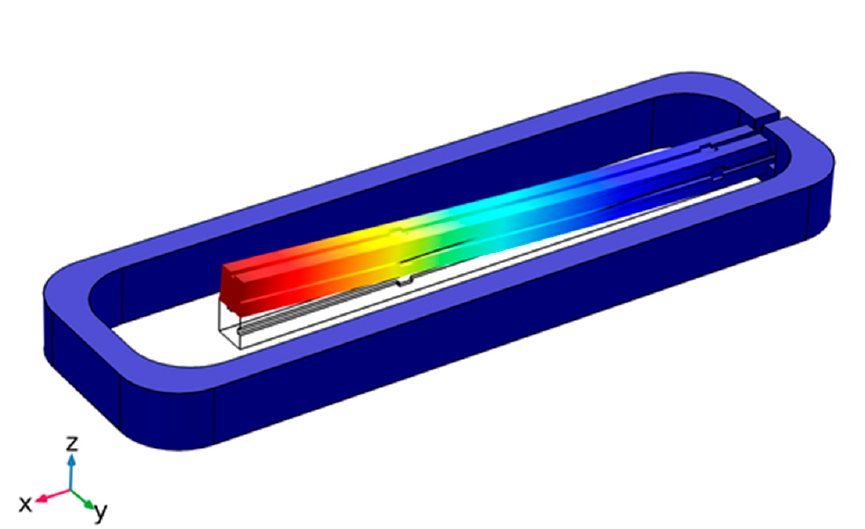
Figure 2. First eigenmode of the printed structure, determined using COMSOL Multiphysics ® . The frequency-dependent deflection of the structure was studied by applying a 10 N load at the cantilever free edge with a harmonic perturbation with frequencies between 10 and 800 Hz. The maximum displacement of the cantilever was calculated and compared with the experimental results for the z-direction, as presented in Figure 3a. The experi- mental data were attained by applying a sinusoidal acceleration with a constant 10 m/s 2 amplitude and a frequency in the range of 10 and 800 Hz. The experimental data were in accordance with those calculated analytically where a maximum fast Fourier transform (FFT) peak value at 250 Hz was attained near the eigenfrequency value and as expected. The same procedure was followed for the y-direction, attaining similar results as presented in Figure 3b. The normalized FFT peaks were determined by calculating the fast Fourier transform of the temporal signal and analyzing the peak with a higher amplitude. The results were then normalized to the highest value. Another important factor is the sensitivity of the FBGs to vibrations applied in differ- ent directions because a small cross-sensitivity grants the directionality of the measure- ments. This means that, in addition to the frequency and the corresponding acceleration, the direction of the vibration can be inferred from the signals provided by the sensors. To study this cross-sensitivity, a vibration in the vertical direction was applied and the output signals from Sensors 1 and 2 were compared. The results, shown in Figure 4, indicate that the structure was capable of directionality in the measurements as the signal amplitude and the corresponding FFT peak were significantly smaller in Sensor 2, which, in turn, was mostly sensitive to the vibrations applied to the horizontal